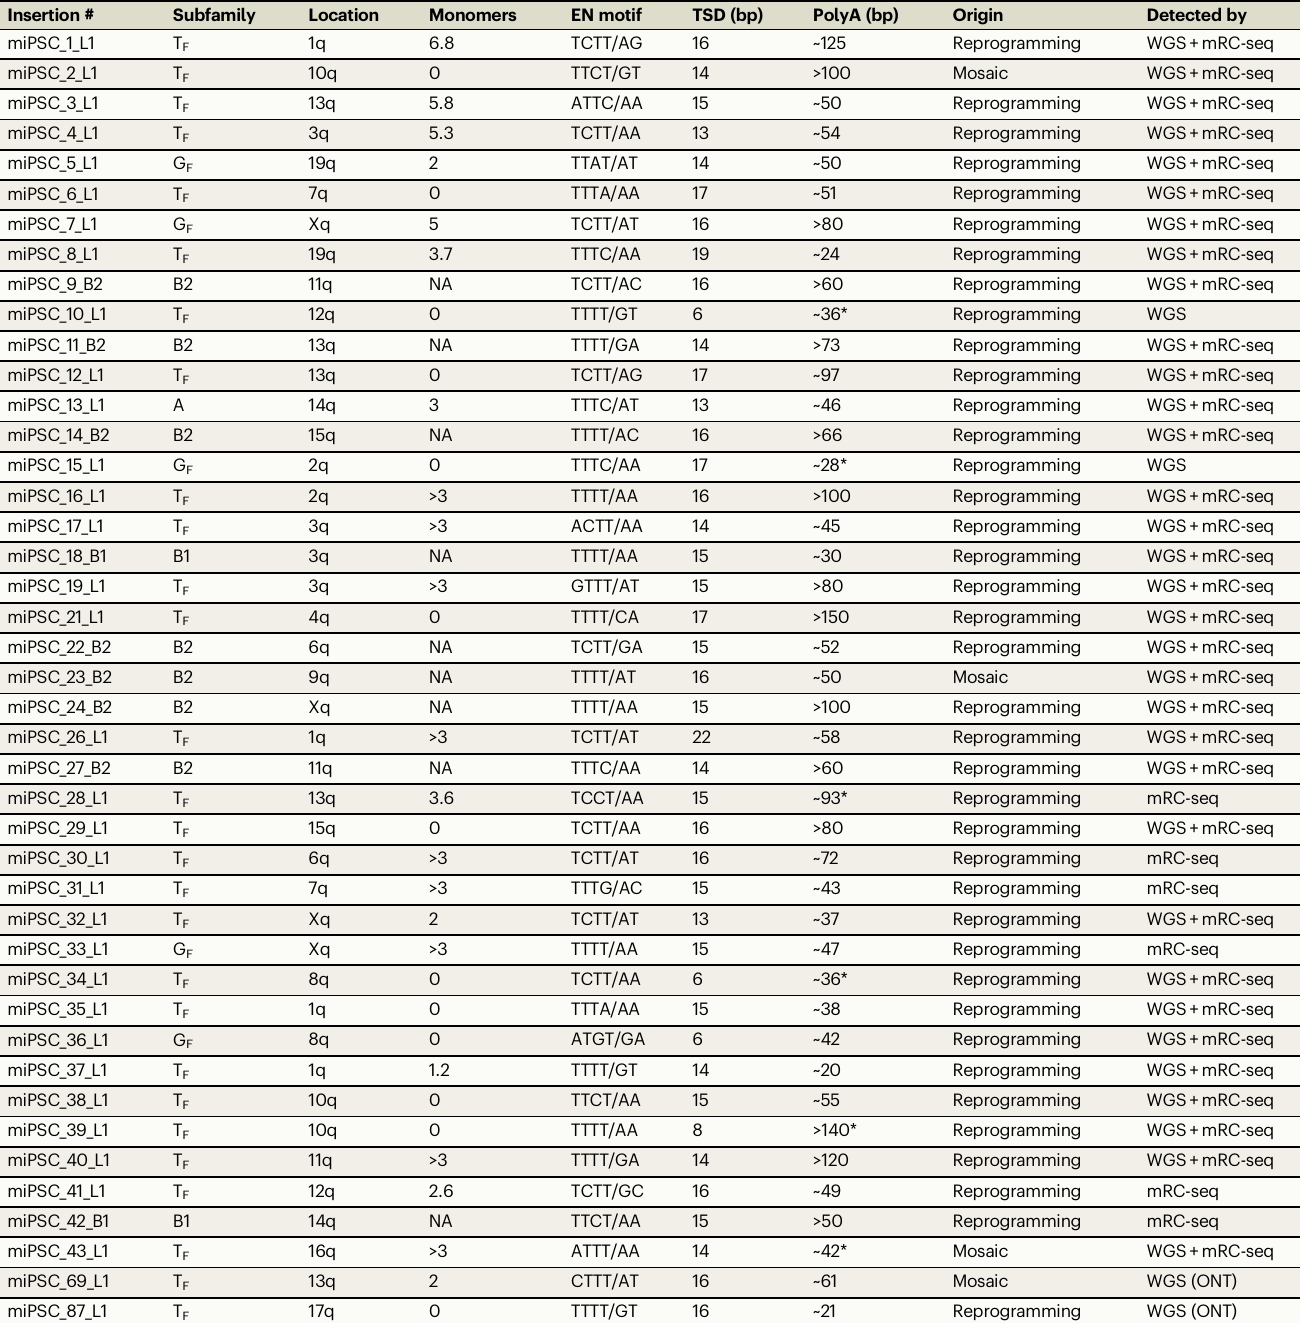
Table 1 | De novo TE insertions detected and PCR validated in miPSC lines Insertion # Subfamily